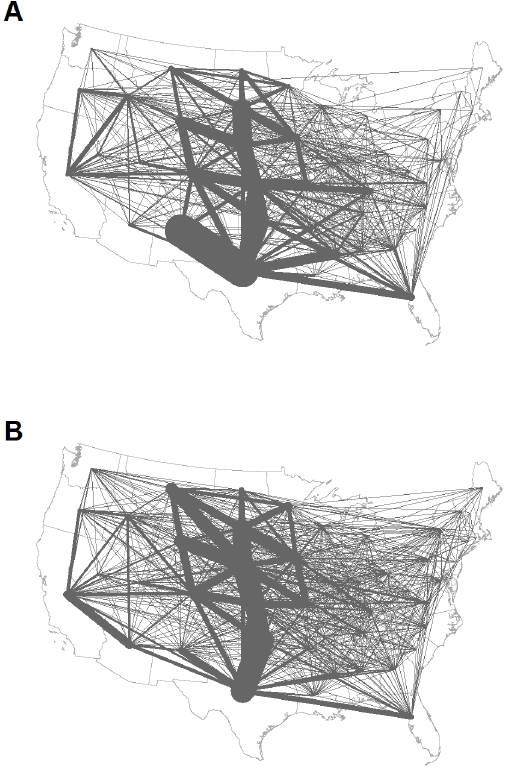
Figure 1. State-to-state cattle flows. Given for the (A) ERS ICVI summary data [16] and (B) 10% sample of paper ICVIs.